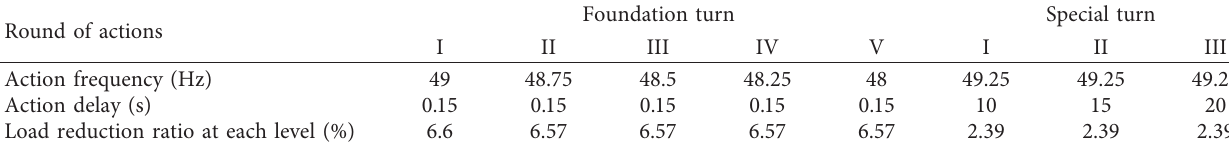
Table 4: Statistical analysis results of frequency endurance capability.